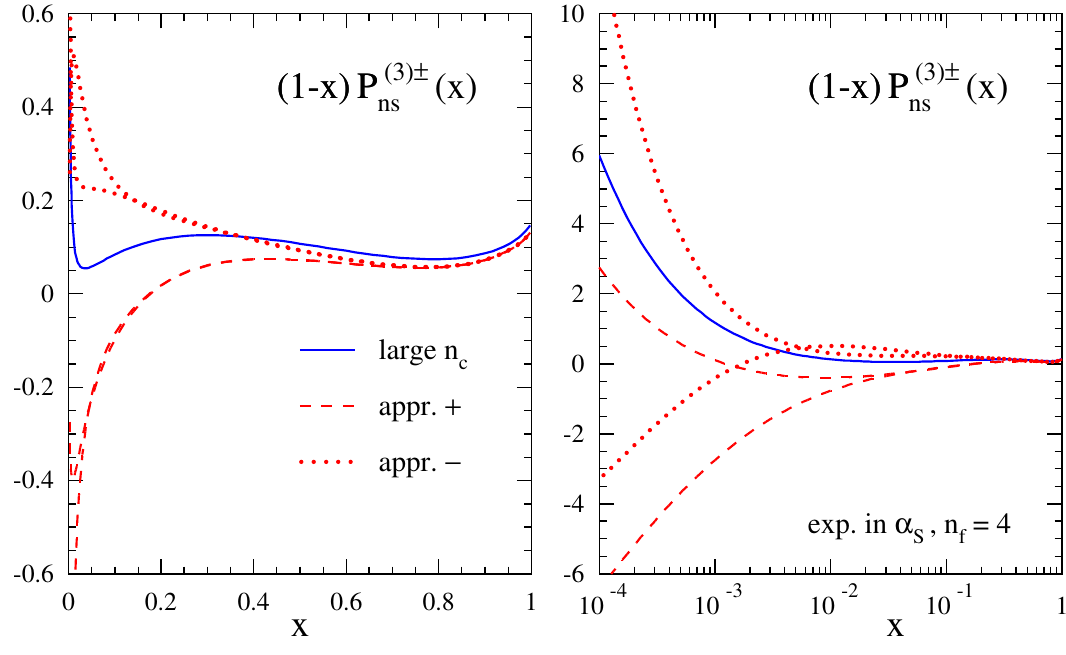
Figure 8 . The four-(cid:13)avour uncertainty bands for the four-loop splitting functions P (3) a ns ( x ) gener- ated by eqs. (4.12) and (4.13) for a = + and by eqs. (4.15) and (4.16) for a = exact large- n c limit. As in (cid:12)gure 7, the curves are scaled to an expansion in (cid:11) s , and only the x < 1 contributions are